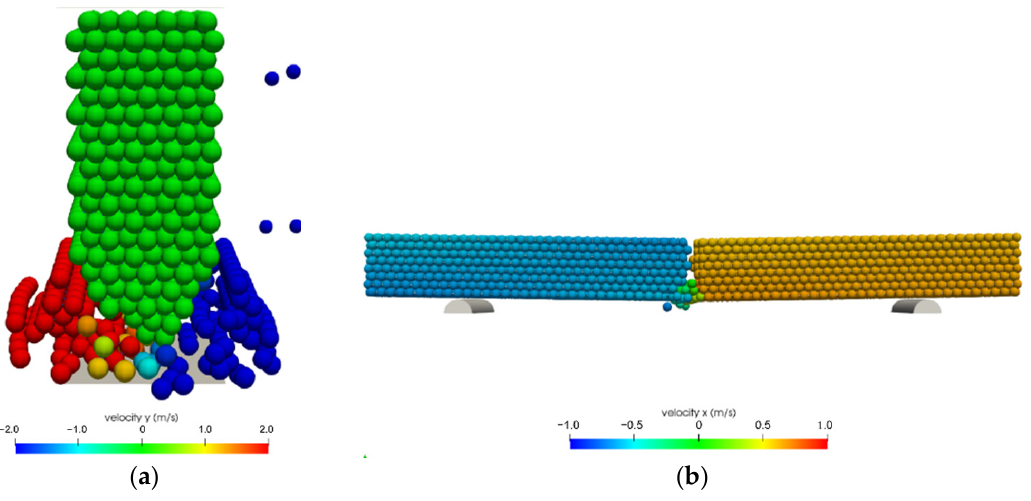
Figure 7. Failure simulation of ice beam: ( a ) uniaxial compressive test; ( b ) three-point bending test.